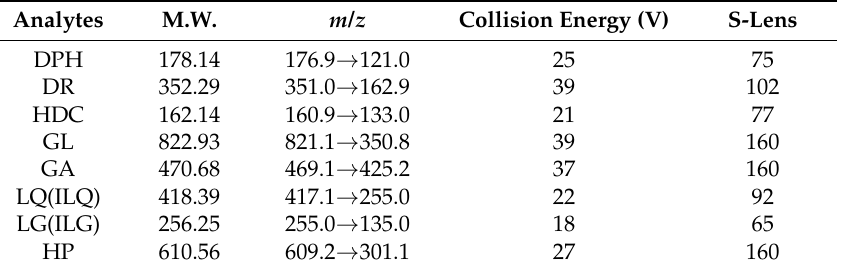
Table 6. The analytical conditions for the LC-MS/MS analysis of DPH, DR, HDC, LQ, ILQ, LG, ILG, GL, GA, and HP. Analytes M.W. m/z Collision Energy (V) S-Lens 178.14 176.9 →